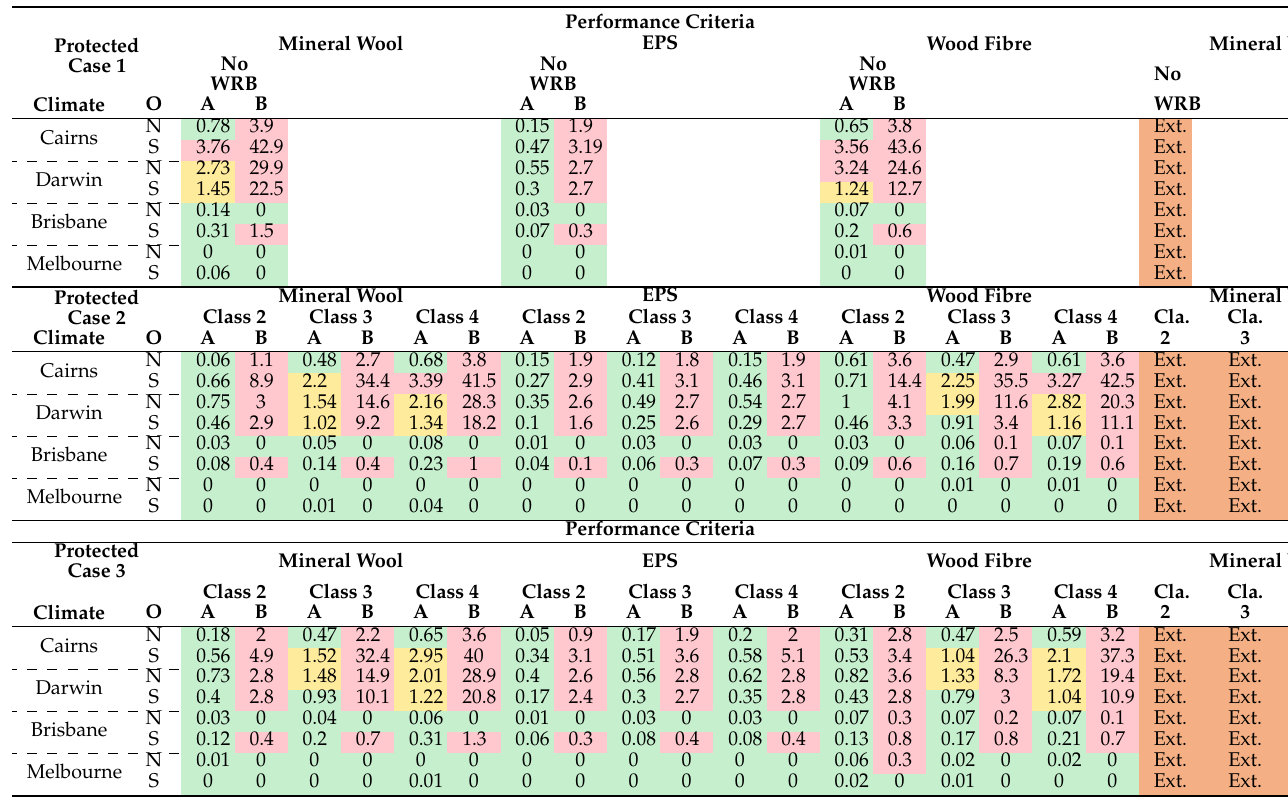
Table A1. Protected CLT results for external insulation. O (orientation). Performance criteria: A (mould growth index), B (corrosion rate). Classification of WRB: Class 2, 3, and 4 (vapour permeance). Green (pass), red (fail), or yellow (further investigation). Critical surface that fails the performance criteria indicated in right table: Ext. (external surface), Int. (internal surface), Both (both